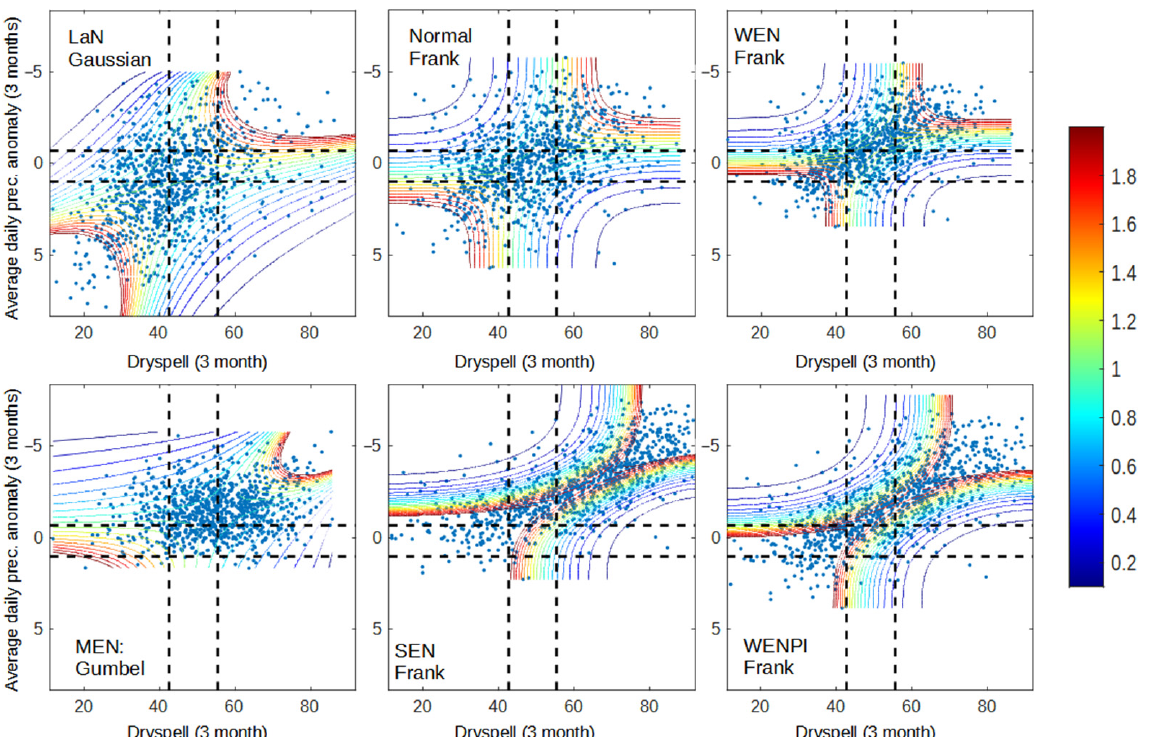
Figure 2. Dependency graph of dry spell and precipitation anomaly for 2001–2020 data. The dashed lines represent the separation of wet ( bottom / left ), normal ( middle ), and dry ( up / right ) conditions for dry spell (vertical line) and precipitation anomaly (horizontal line).